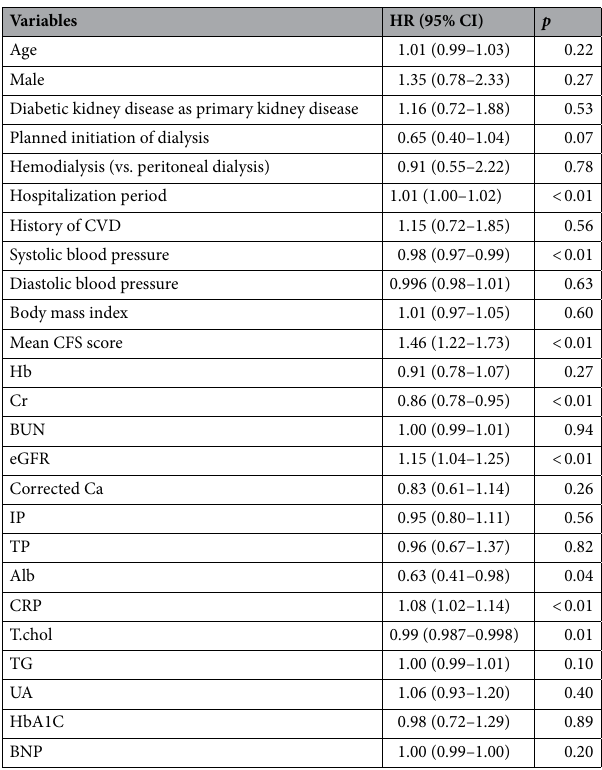
Table 3. Results of univariate cox proportional hazards model analyses for 2-year mortality or hospitalization.